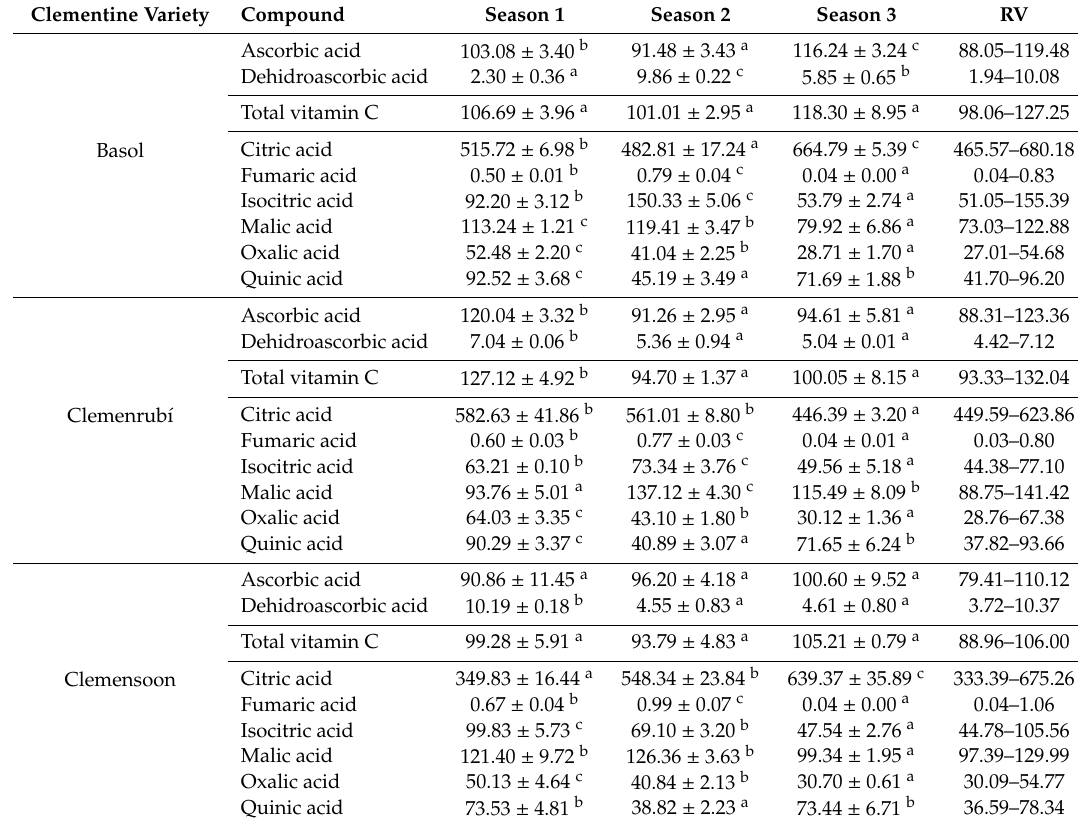
Table 4. Vitamin C (total, ascorbic and dehidroascorbic acid) and other organic acids (mg / 100 g fw of fruit edible portion) in extra early clementine varieties.